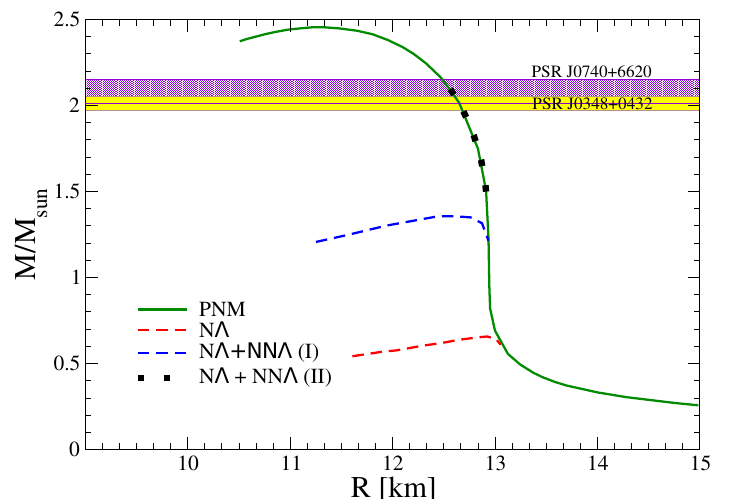
Figure 5. Mass-radius relations according to the AFDMC calculations proposed in Ref. [215]. The observed pulsars PSR J0348+0432 [103] and PSR J0740+6620 [104] which are represented by yellow and purple bands, respectively, indicate the uncertainty on the measurement. See text for details.